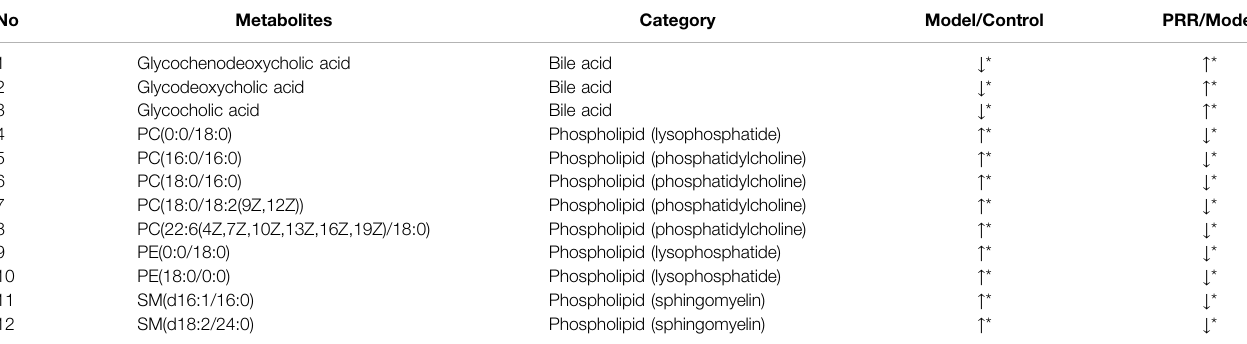
Model/Control represented the comparison between BS group and control group B; PRR/Model represented the comparison between PRR-treated group B and BS group. ↓ denoted down-regulation; ↑ denoted up-regulation; *p <